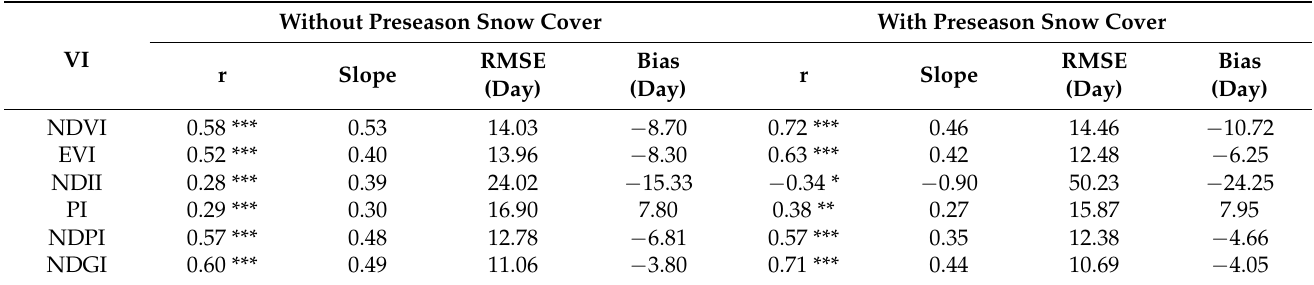
Table 1. Comparison between ground-observed GUD and satellite-observed GUDs detected from six VIs by CCR max for site-years with and without preseason snow